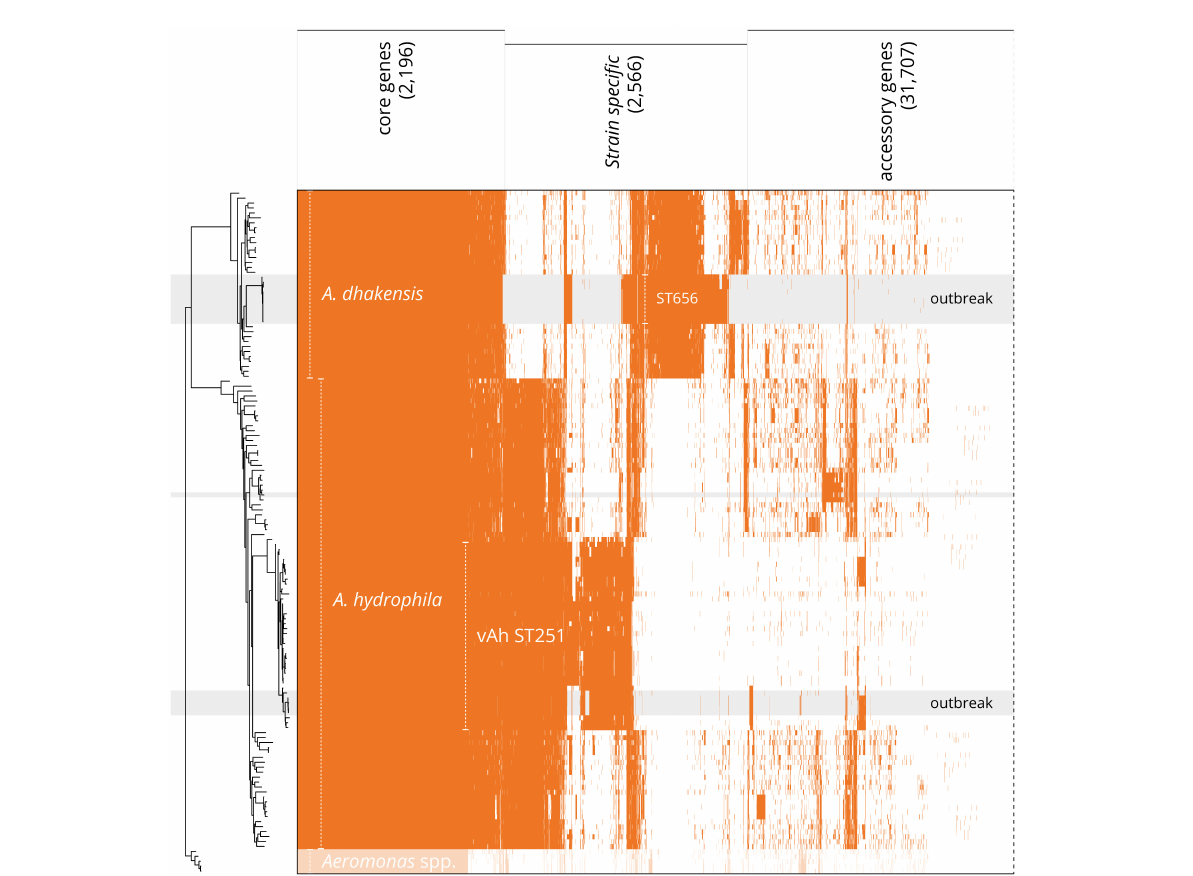
FIGURE4 Distribution of protein-encoding genes in the pan-genome of A. hydrophila and A. dhakensis . Tree is based on pan-genome analysis, calculated by PIRATE using the accessory genes. Gray background indicates isolates sequenced de novo in this present study, with field isolates labeled “outbreak”. Shared protein-encoding genes constitute the core genome (95% presence; 2,517 genes). A. dhakensis has species-specific genes (698 genes) whilst the outbreak strains (ST656, from this present study) share a cluster of clone-specific genes (additional 769 genes).